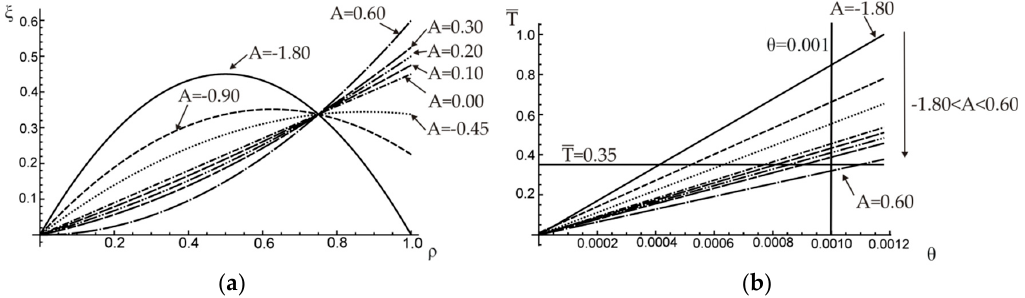
ξ ρ along radius of the bar; ( b ) torque versus unit angle